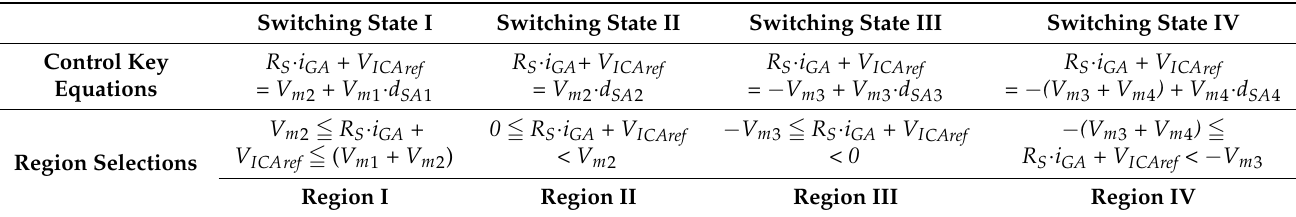
Table 2. Control key equations for four operation regions of phase